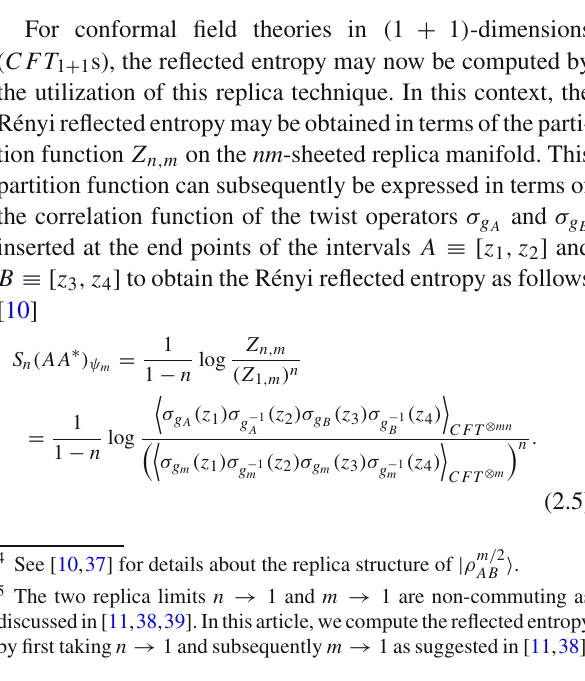
and σ g , respec- A B